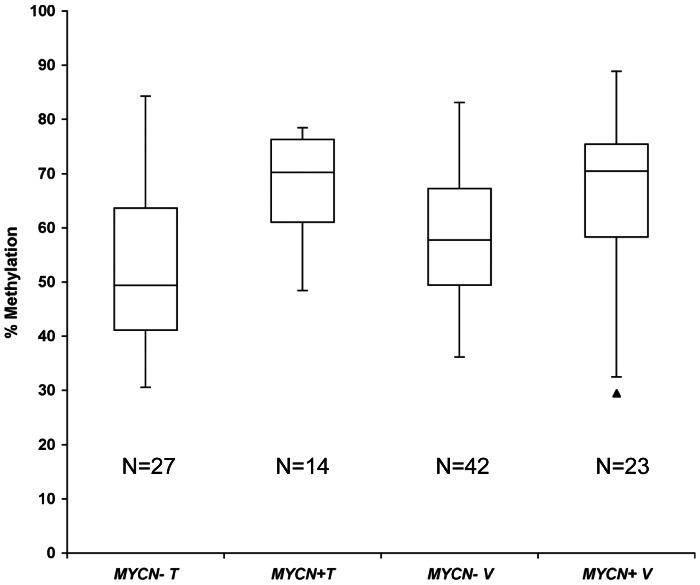
Distribution of methylation values for PCDHB in HR patients subdivided according to the MYCN amplification status (+: amplified; −: single copy) in the training (T) and in the validation set (V).